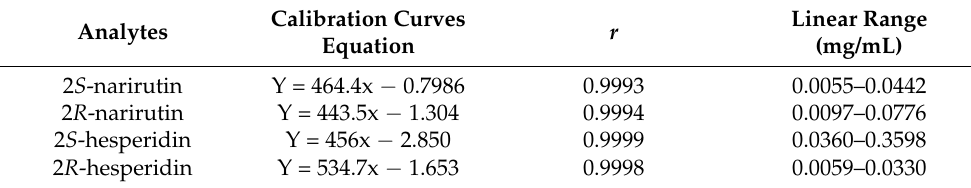
Table 2. Regression equations, linear range for four analytes.